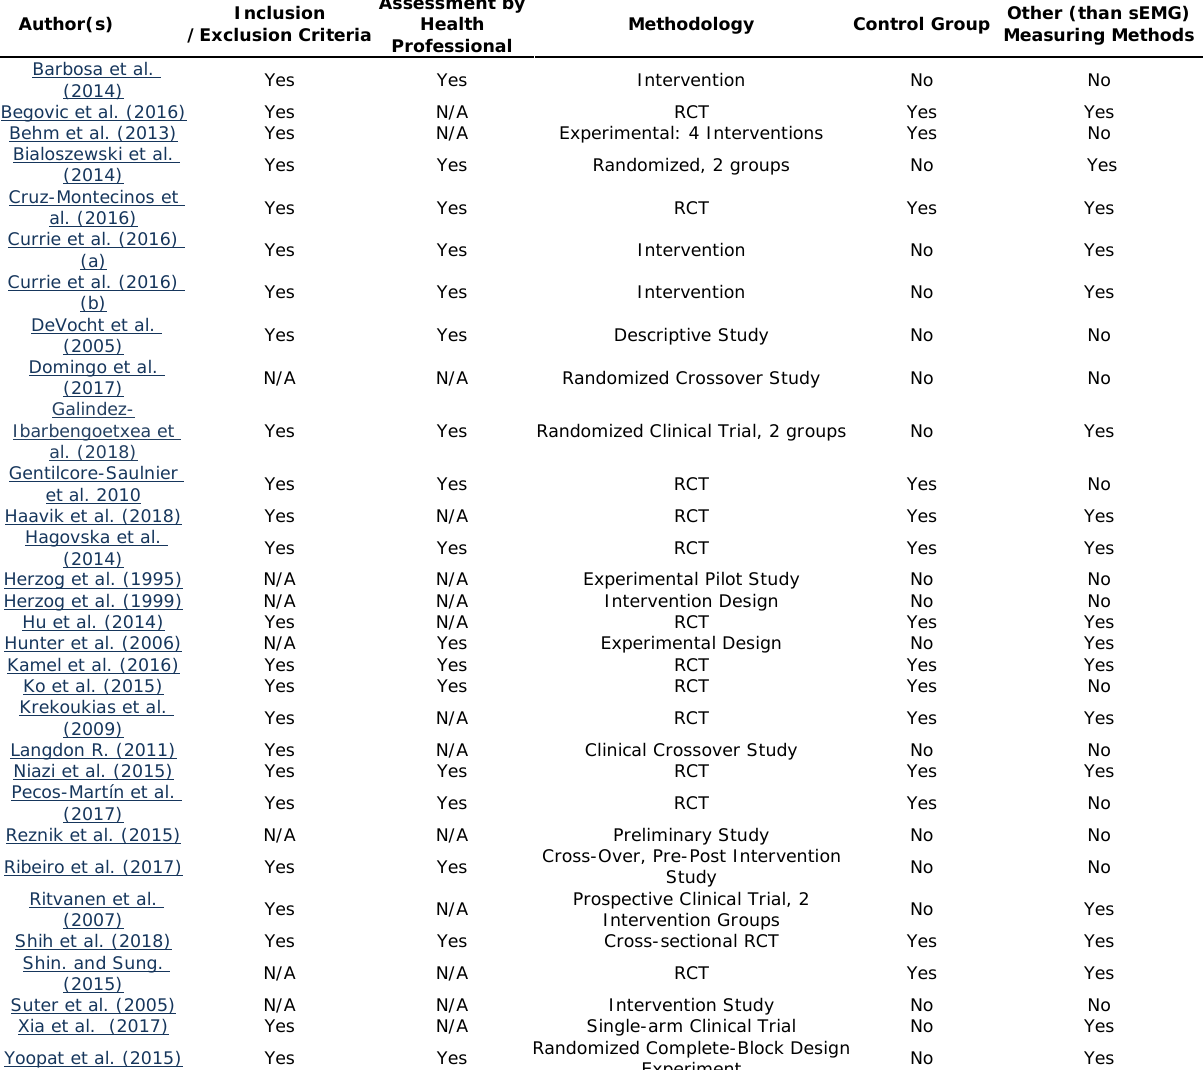
Table 2. Use of sEMG in Manual Therapy: